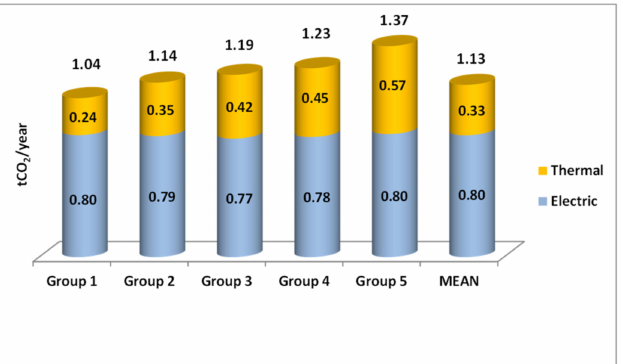
Figure 16. Thermal, electric, and total CO 2 emissions per inhabitant by group of cities without the influence of